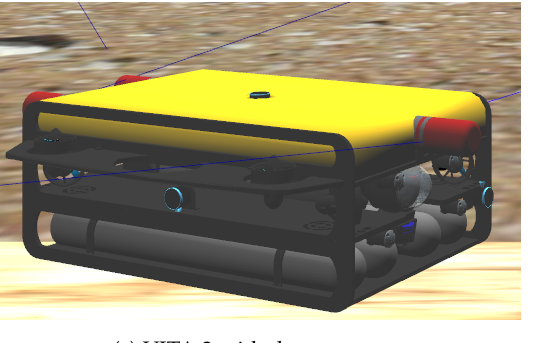
Figure 11. Robots positioned in the entrance of the tunnel. In ( a ), the vector in red depicts the robot heading vector, while the green vector is the ray of the sensor which is always co-planar with the cross-section of the tunnel. Blue lines depict the ping rays of four ping sensors which are used to keep the two robots centered at the cross-section of the tunnel as they move. In ( b – d ) we see VITA 2 with several 881L